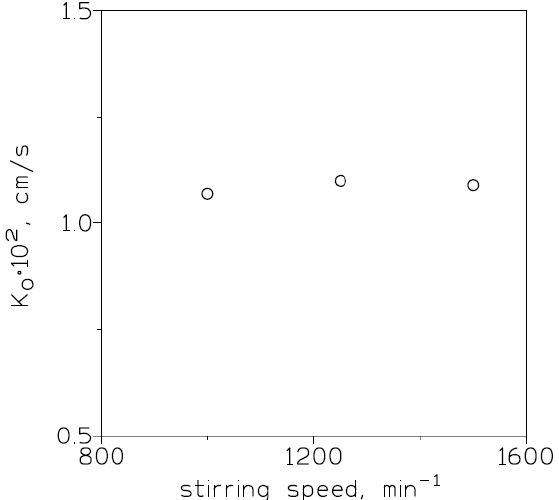
Figure 2. Overall mass transfer coefficients versus stirring speeds (feed phase) for chromium(VI) transport using Cyanex 921 in Solvesso 100 as mobile carrier. Support: GVHP4700.